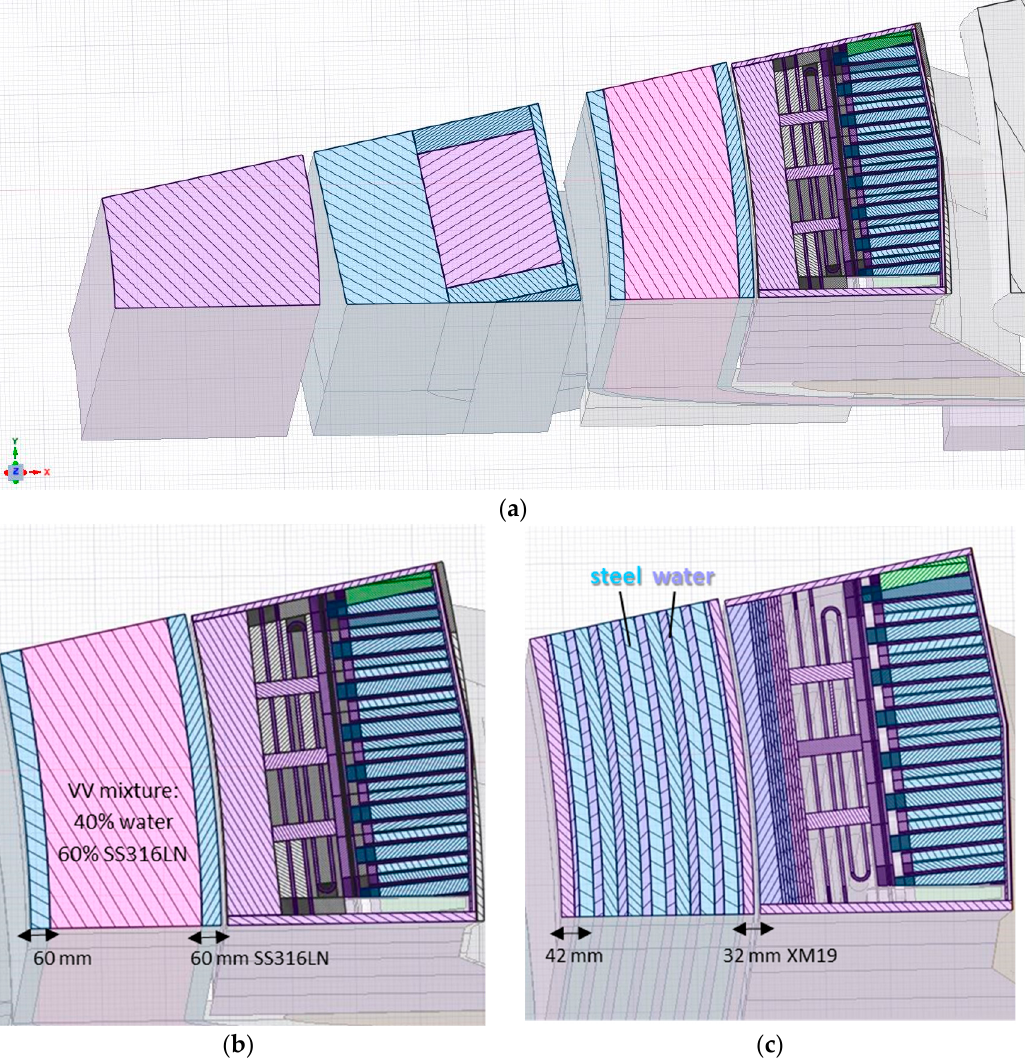
Figure 9. Horizontal section at equatorial level of the neutronic HCPB model ( a ); detail of the standard VV in the homogenized neutronic model ( b ); VV novel configuration with ribs ( c ).